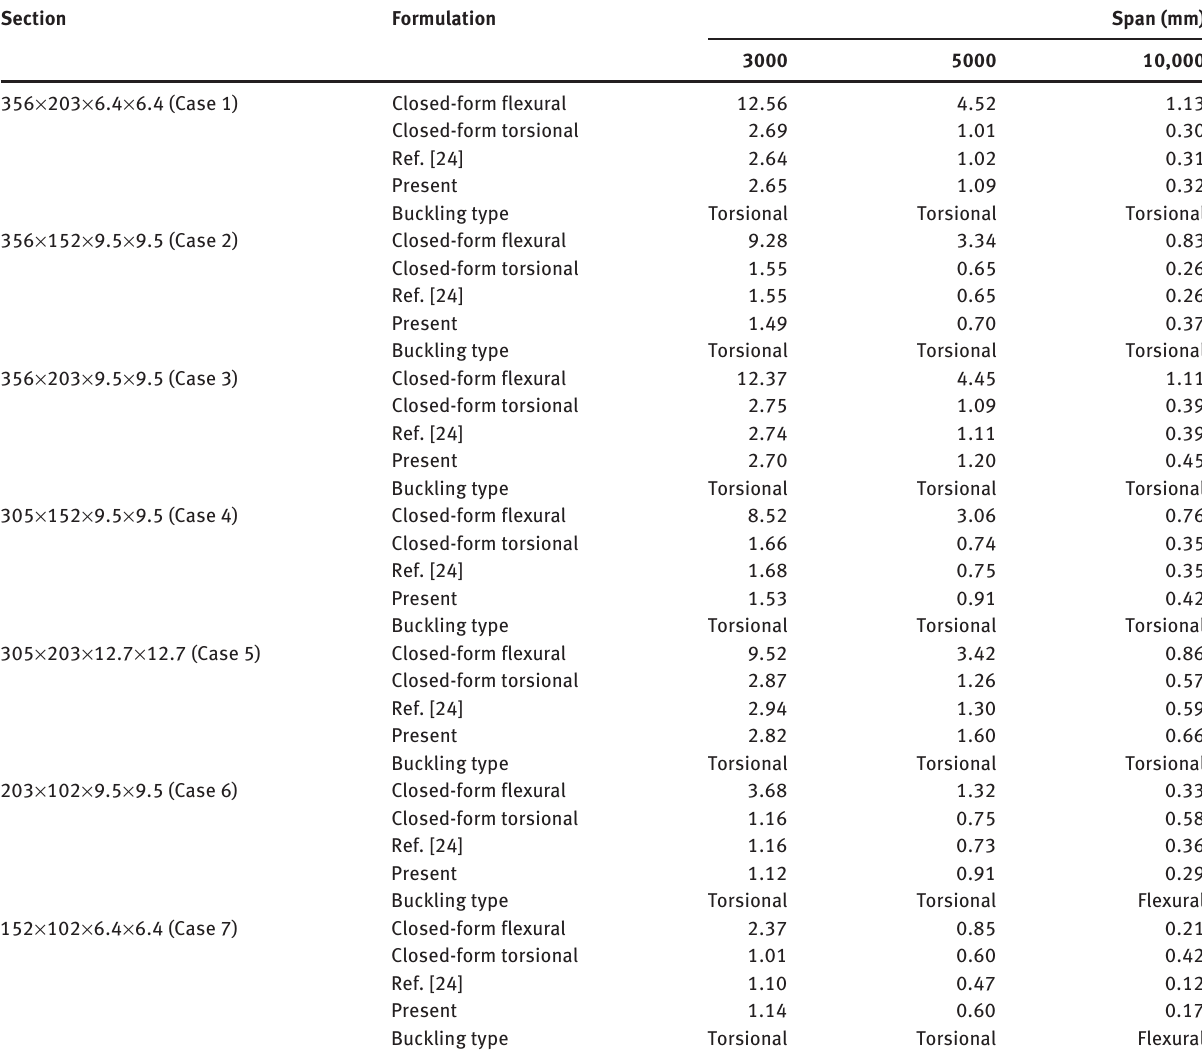
Table 6 Normalized critical buckling stresses of FRP stiffened cruciform-shaped section